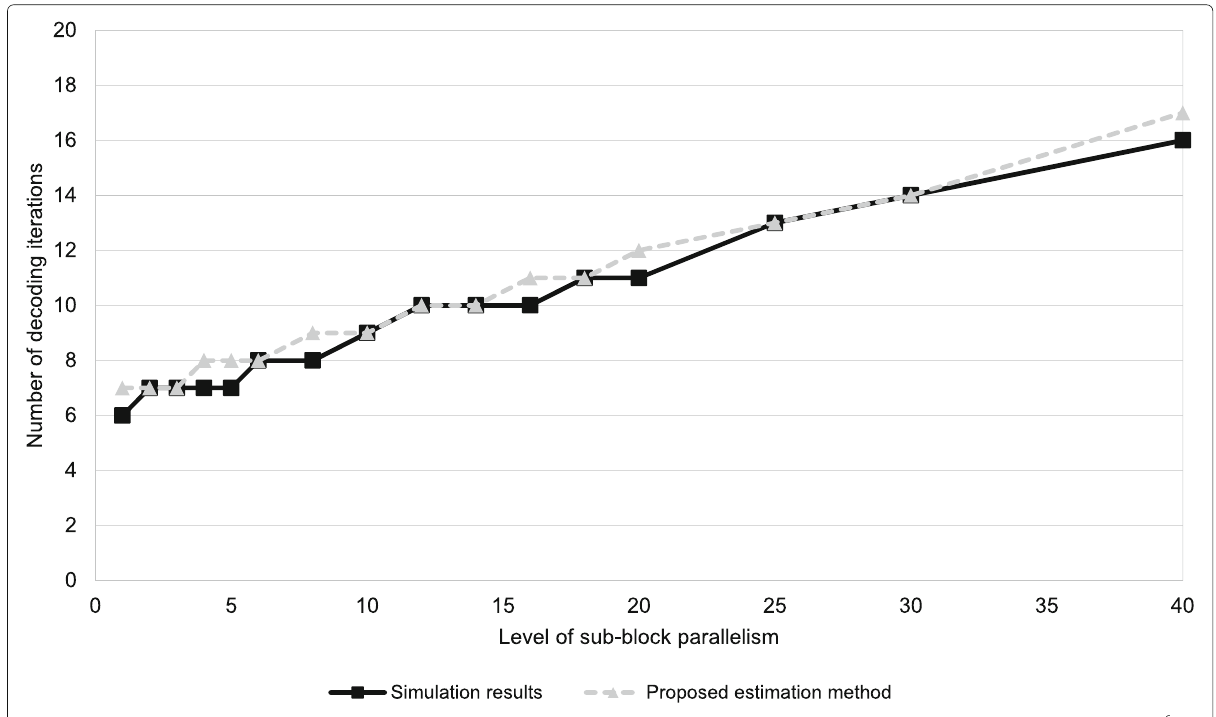
Fig. 5 Number of iterations with message passing method, WiMAX, Max-Log MAP, code rate=5/6, 960 bits frame, SNR = 4.5 dB, BER = 6.6 × 10 −